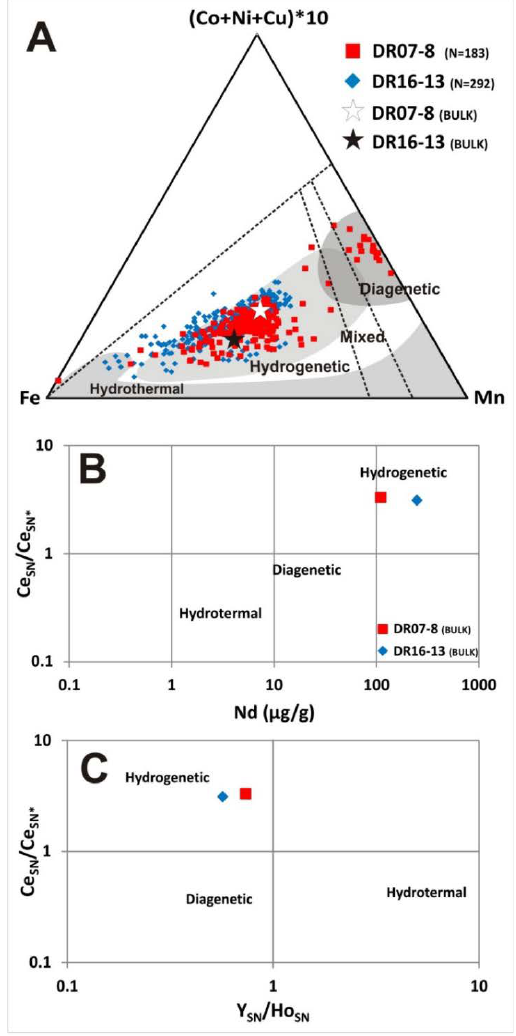
Figure 12. ( A ) Ternary diagram modified from [18,72,73]. Bulk analysis is represented by stars plotted in the hydrogenetic field and compared with hundreds of EPMA spot analyses that are plotted in the diagenetic field; ( B , C ) Binary diagrams of bulk REYs data (after [74]) are also plotted in the hydrogenetic field. hydrogenetic